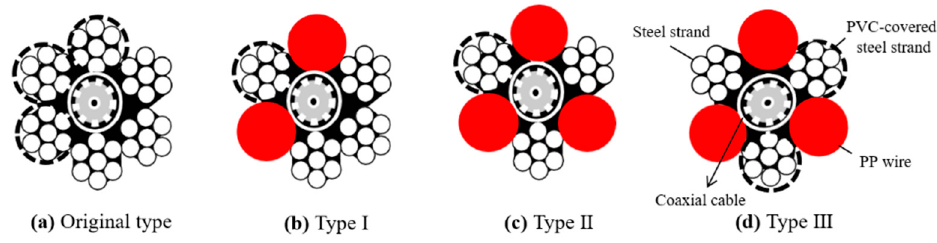
Figure 2. Waveguide configurations: the original TDR sensing cable ( a ); and the three newly- proposed types ( b – d ). All diameters are 8 mm except for the bare steel strand, which is 6 mm in